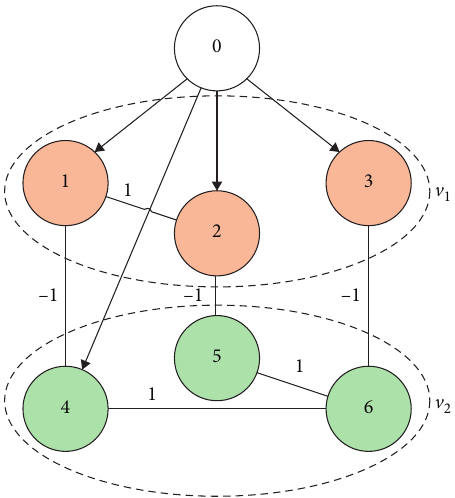
Figure 1: A network with competitive interactions containing 7